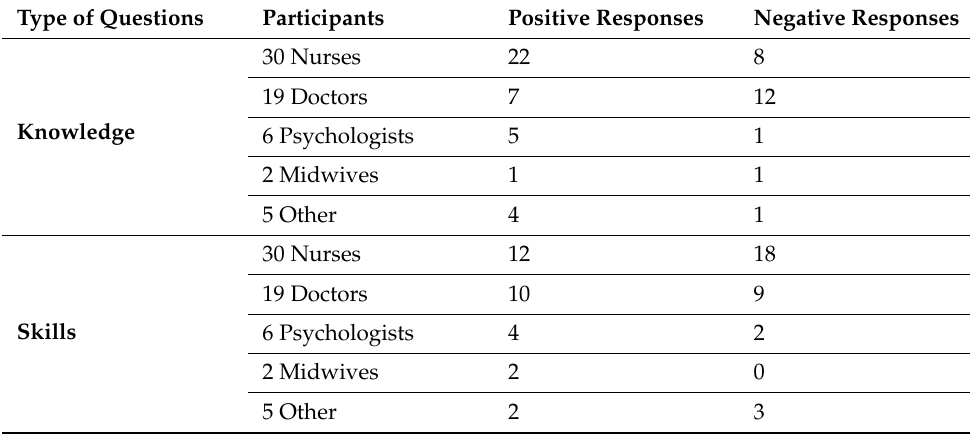
Table 5. Interview